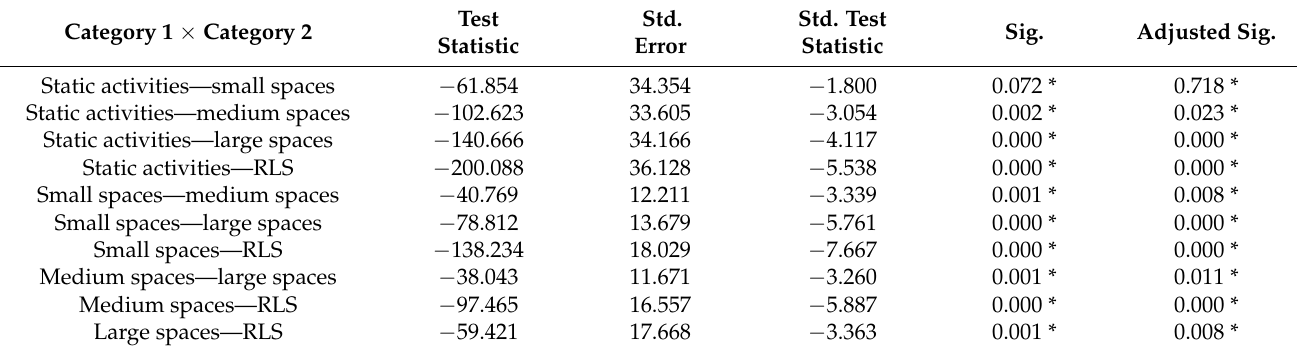
Figure 2. Results of the differences in the eTL according to the game space. Note: the circle represents the outliers, while the asterisk represents the extreme values. Table 5 shows the pairwise comparisons (for the eTL) of the game space categories. static activities and small spaces (adjusted p > 0.05). Table 5. Pairwise comparisons (for the eTL) of the game space categories.